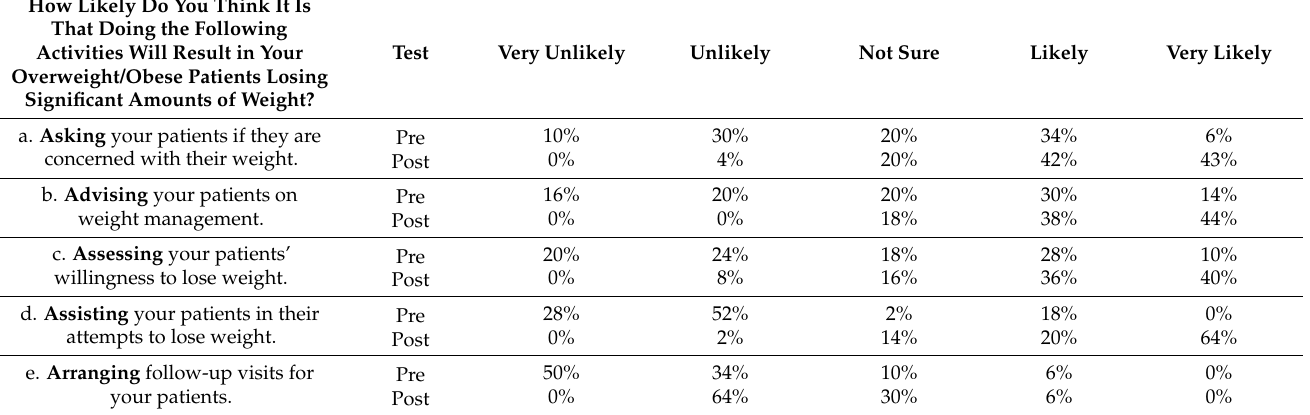
Table 4. Questionnaire Item 13 Response Frequency